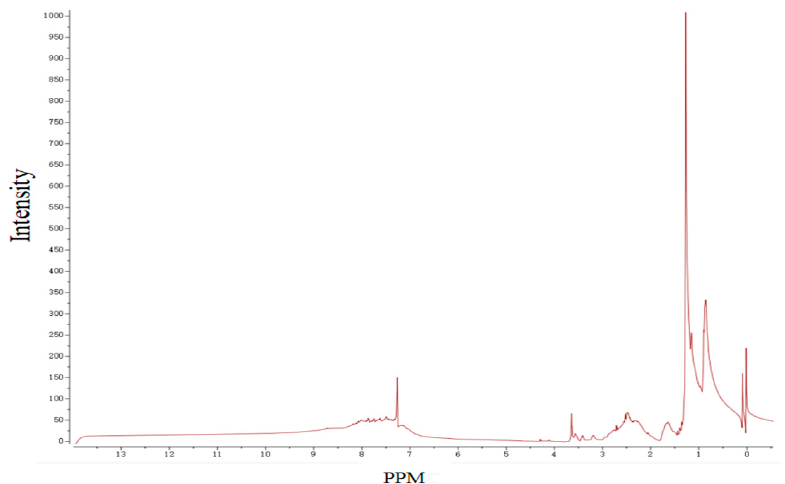
Figure 4. 1 H-NMR spectrum of VLSFO asphaltene.